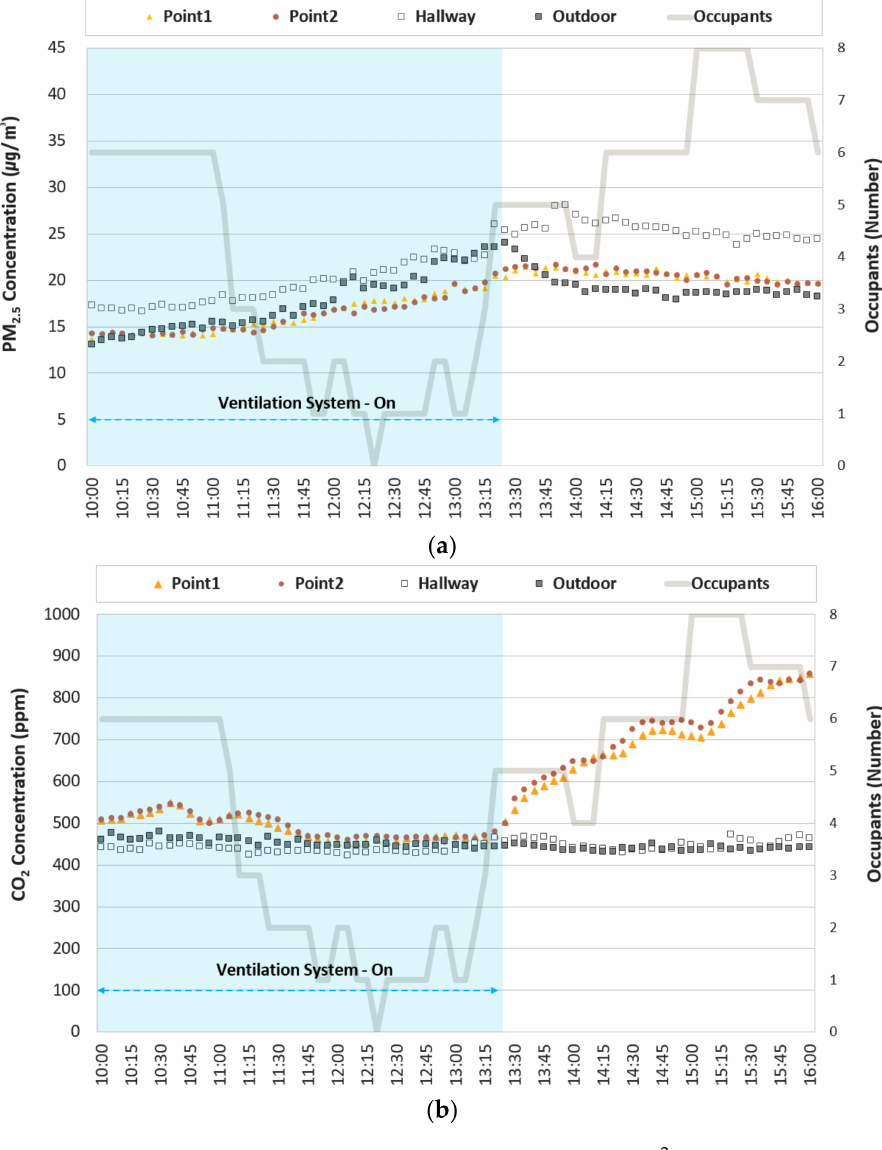
Figure 6. PM 2.5 and CO 2 indoor air quality test results for a 60.43-m 2 office space on 12 August 2021. ( a ) PM 2.5 concentration; ( b ) CO 2